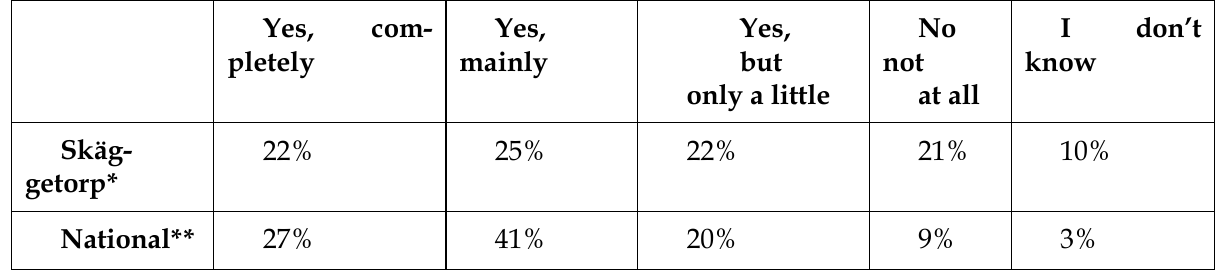
Table 2. * Our survey, n=323 (all respondents in our survey). ** Swedish Internet Foundation 2019. In comparison with the nationwide survey, where 9% reported that they do not feel included at all, 21% reported this alternative in our survey. In the nationwide survey 88% of the respondents reported one of the three alternatives about feeling included in digital society. In our survey only 69% reported these alternatives. The difference is considerable, yet, the samples are